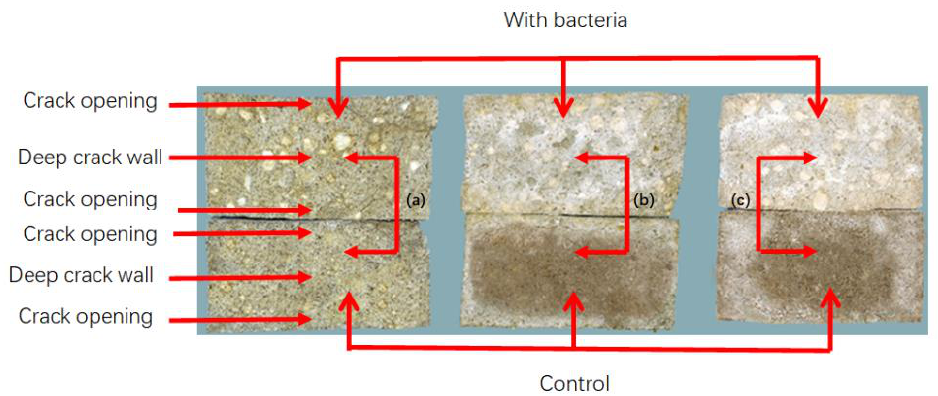
Figure 7. Healing products in crack wall of mortar specimens after healing for 56 d under different exposure environments: ( a ) standard curing; ( b ) dry – wet cycle; ( c ) water curing. exposure environments: ( a ) standard curing; ( b ) dry–wet cycle; ( c ) water